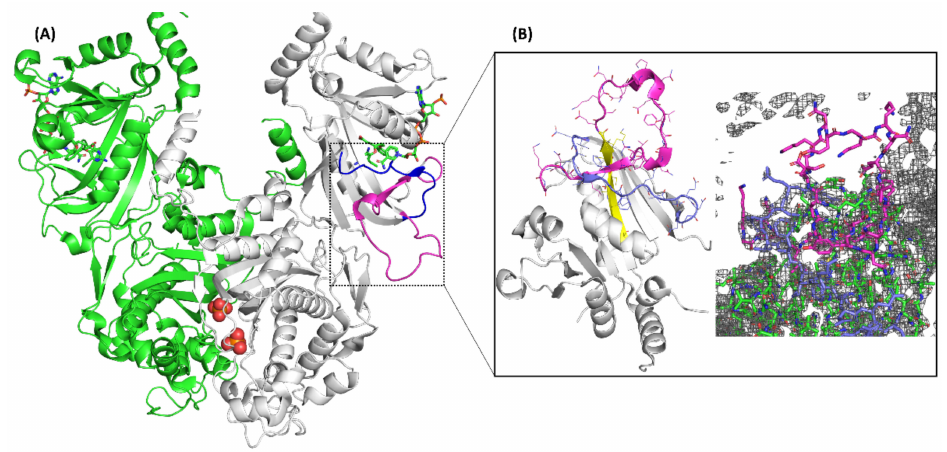
Figure 3. ( A ) Experimental DHFR-TS homodimer structure (PDB ID; 4DP3) coloured in green and white. The NADP cofactor and ligand represented in green stick and phosphate ion as red spheres. Loop 1 is coloured in magenta and loop 2 coloured in blue. A beta-strand clashing with that of loop 1 is coloured in yellow. ( B ) Zoomed in portion showing the absence of electron densities in the experimental structure for loop 1.